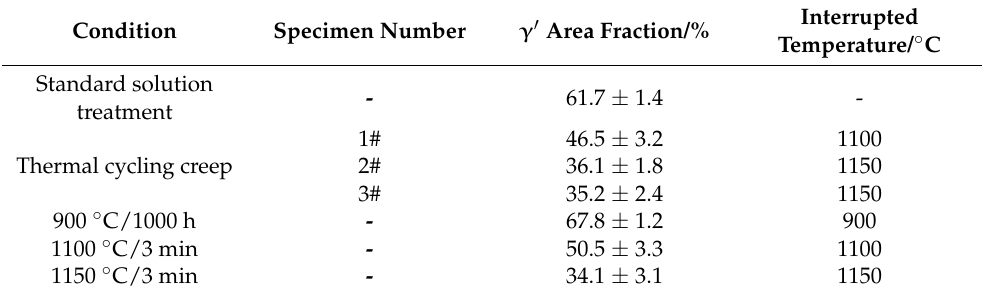
Table 2. Area fraction of γ (cid:48) precipitates in the dendrite core regions of K465 superalloy after the standard solution treatment, during thermal cycling creep under different conditions and after heat treatment at 900–1150 ◦